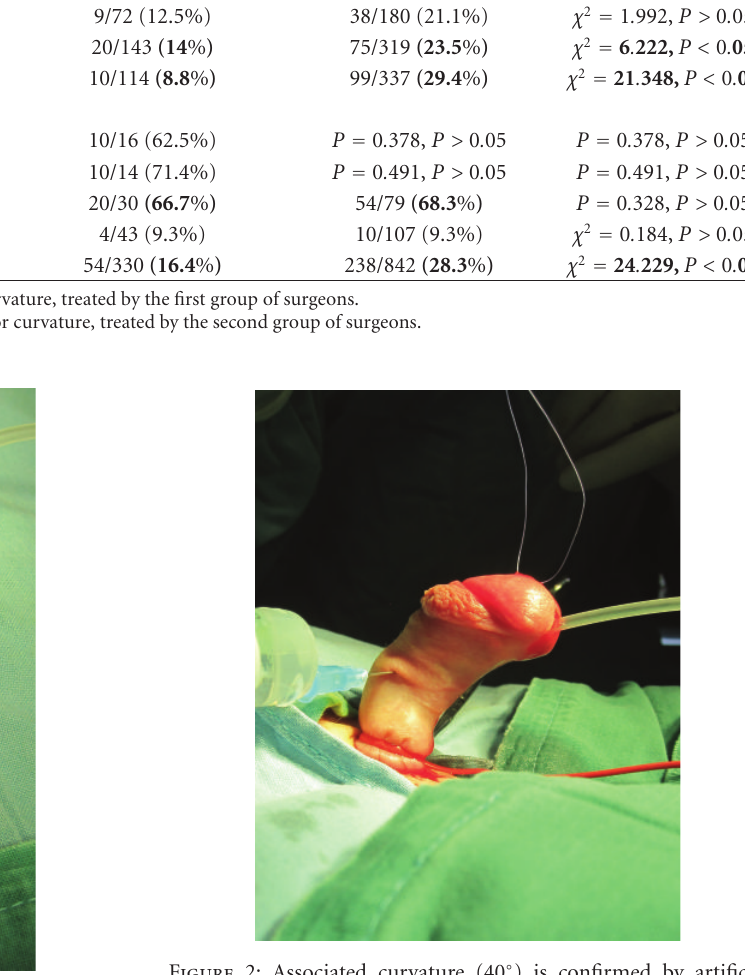
Figure 1: Glanular hypospadias.